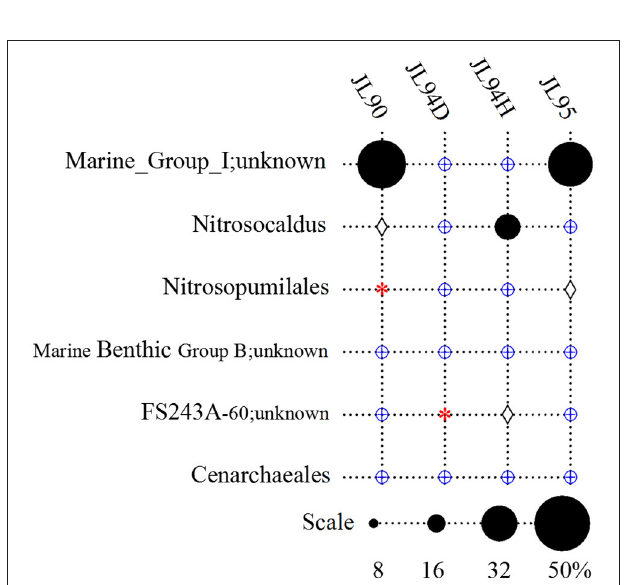
FIGURE 3 | Taxonomic relative abundance of Thaumarchaeota genera observed in chimney samples. DHVEG-6, Deep Sea Hydrothermal Vent Group 6. Groups in which no tags were sequenced are indicated with a red asterisk. Groups which were detected below1% are indicated with a blue oplus, between 1 and 2% are indicated with a